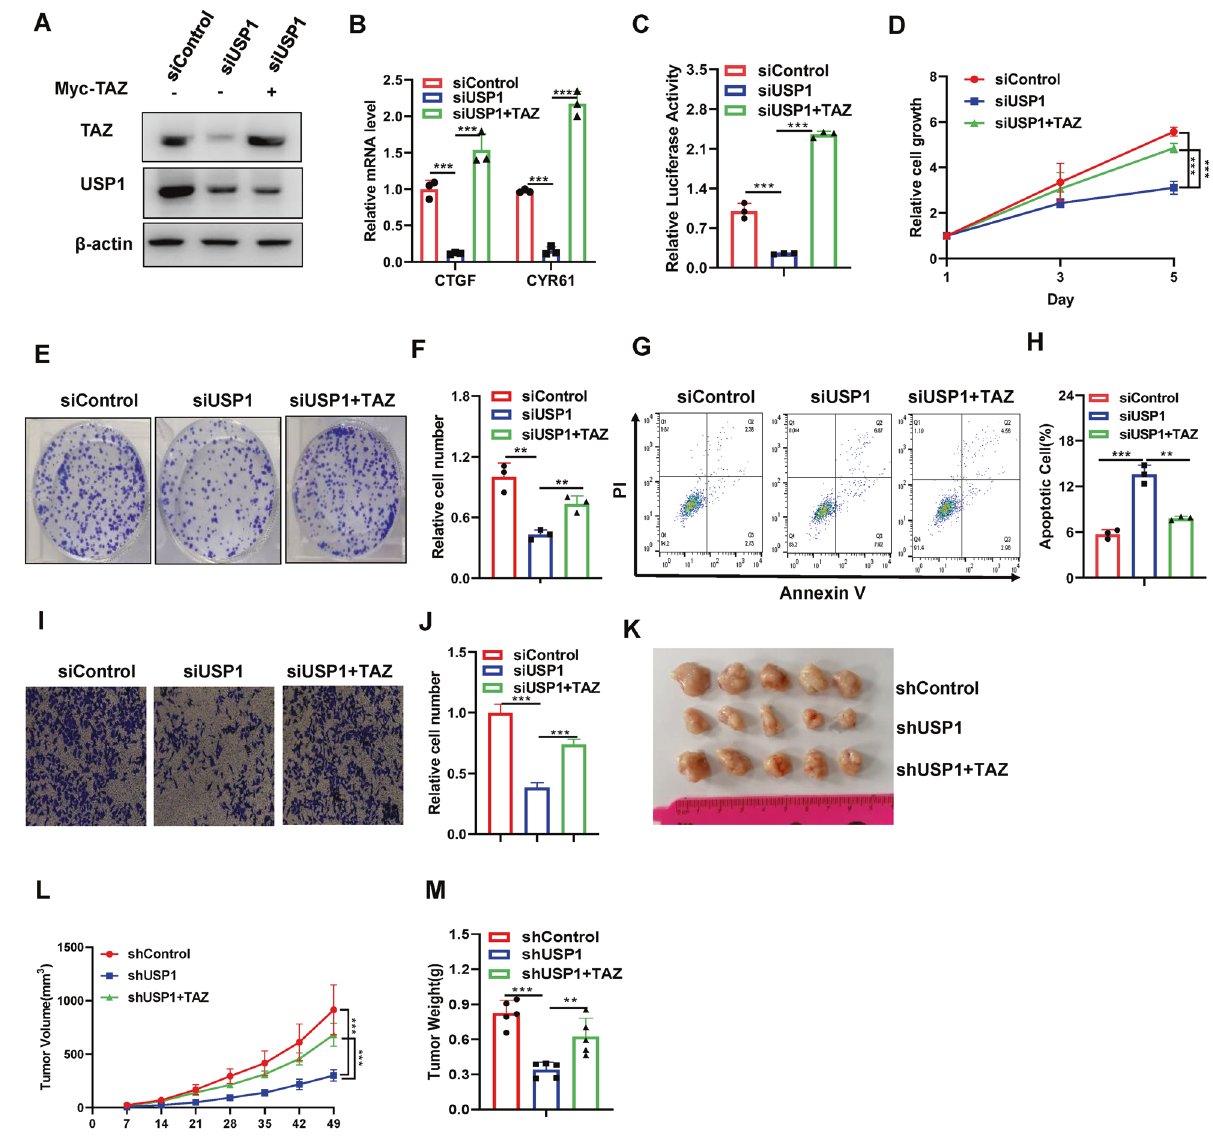
Fig. 4 Hepatocellular carcinomas with TAZ overexpression display partial reversal of the antitumor effects of USP1 depletion. A Western blot analysis of TAZ and USP1 expression in HLF cells treated with siControl or siUSP1 for 24 h, then transfected with Myc or Myc-TAZ for another 24 h. In this study, β -Actin was used as the internal reference. B Results of RT ‒ qPCR to measure CTGF and CYR61 mRNA levels in HLF cells treated as indicated. C TEAD response element transcriptional activity was measured via luciferase reporter assays with tandem TEAD- binding sites in HLF cells treated as indicated. D At the indicated time points, a CCK-8 assay was performed to determine the viability of HLF cells treated as indicated. E , F Colony formation (left panel) of HLF cells treated as indicated. F shows the quantitative analysis of the colony formation assay results. G , H FACS analysis (left panel) was performed on HLF cells treated as indicated. I , J Transwell assays was performed on HLF cells transfected treated as indicated. K As indicated, images of tumors derived from nude mice injected with shControl, shUSP1- or shUSP1 + TAZ-transfected HLF cells are shown. L , M Tumor volume ( L ) and weight ( M ) in nude mice injected with stably transfected shControl, shUSP1, or shUSP1 + TAZ HLF cells. In Panels A – J , the results are representative of three independent experiments. In Panels K – M , the results are representative of fi ve independent experiments. The data are presented as the means ± SDs. ** P < 0.01, *** P < 0.001 (Student ’ s t induced reduction in the TAZ protein level in HLF cells (Fig. 5F). Consistent with this fi nding, USP1 overexpression in HEK293 cells appeared to increase the TAZ protein level, and this effect was minimized by MG132 treatment (Fig. 5I). According to these data, we proposed that USP1 modulates the protein level of TAZ via the proteasomal degradation system. In addition, we further eval- uated TAZ protein stability in HLF cells with USP1 silencing and found that USP1 depletion greatly decreased TAZ protein stability (Fig. 5G, H). This fi nding was further con fi rmed in HEK293 cells via USP1 overexpression (Fig. 5J, K).